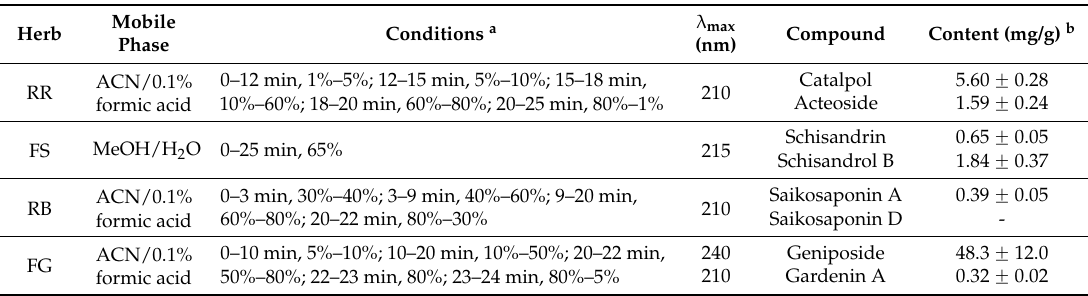
Table 1. Measurement of bioactive constituents of Radix Rehmanniae (RR), Fructus Schisandrae (FS), Radix Bupleuri (RB) and Fructus Gardeniae